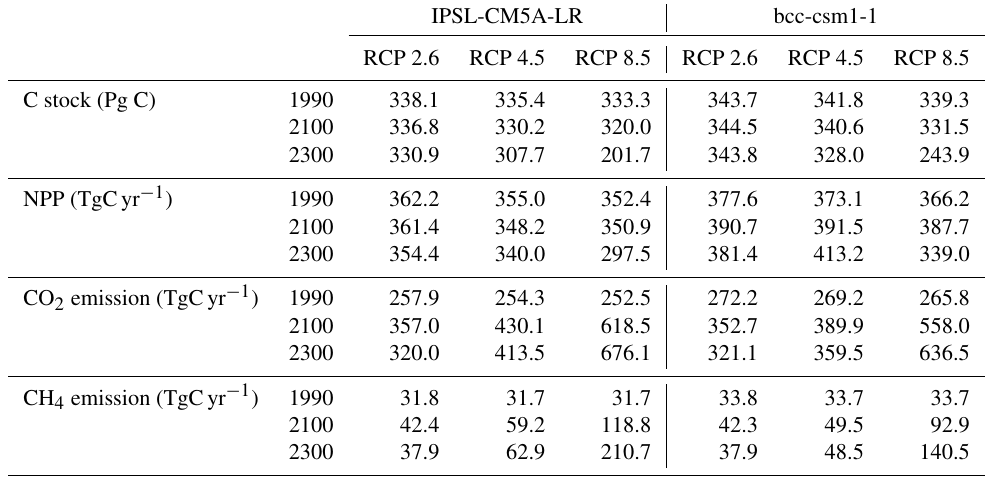
Table 2. Pan-Arctic total C stock and annual C fluxes in 1990, 2100 and 2300.